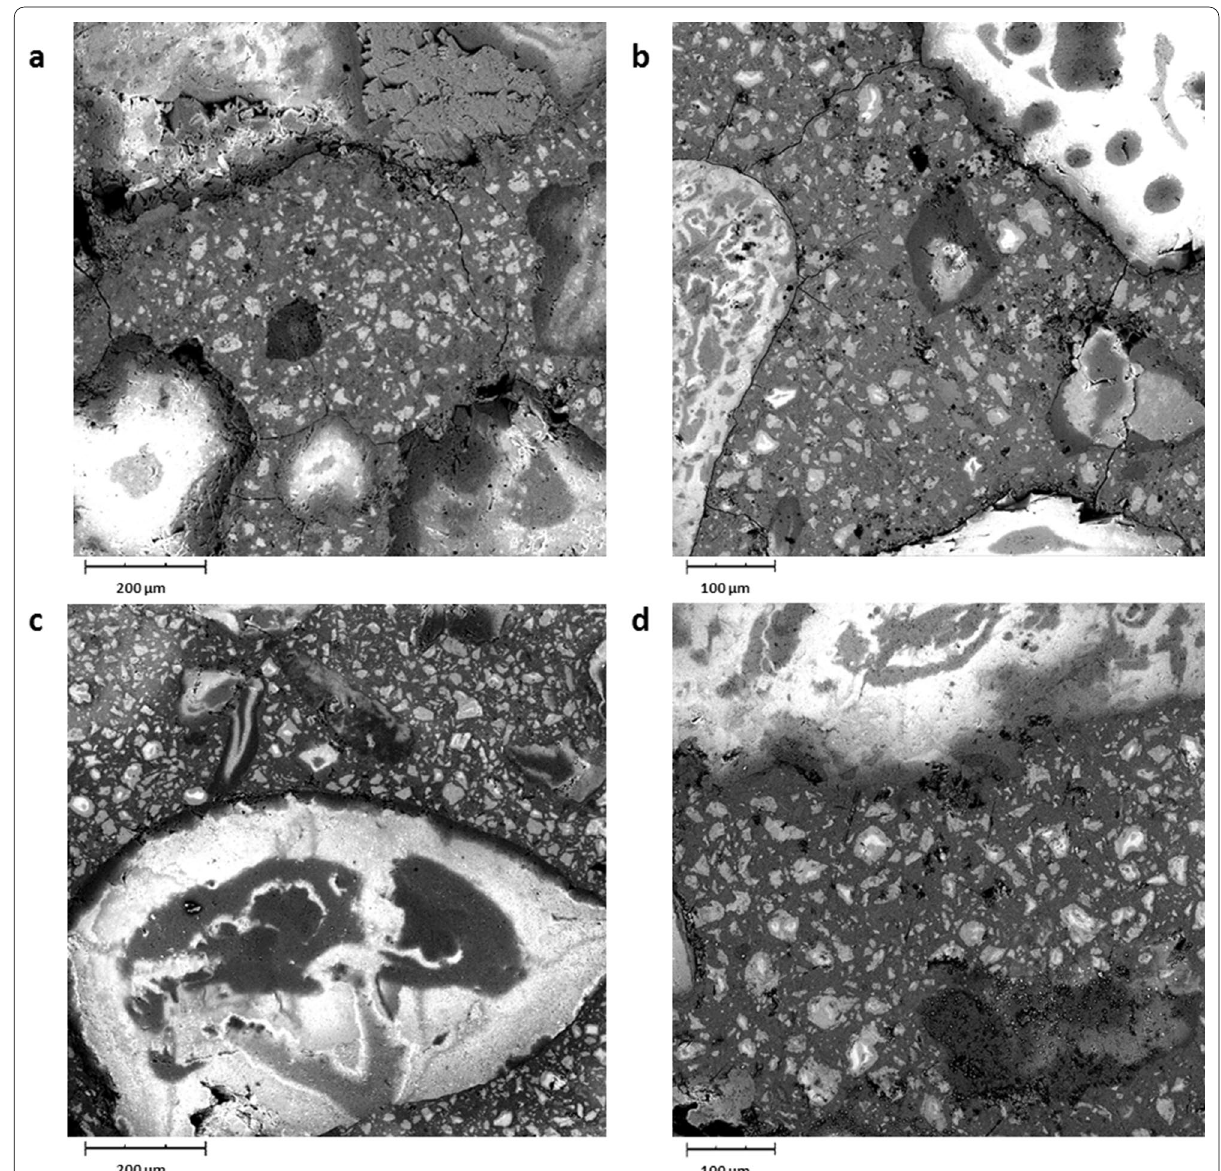
Fig. 11 SEM images: a with visible cracks radial to aggregates in irradiated samples, b with visible cracks along aggregate perimeter and radial cracks in irradiated samples, c and d without significant cracks in control